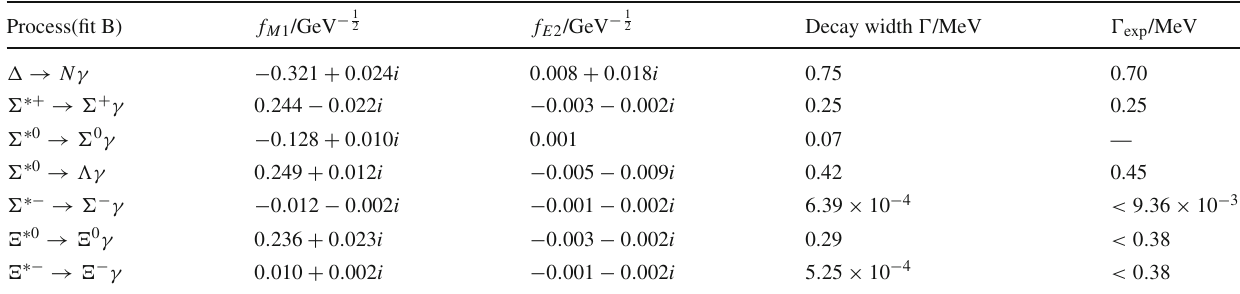
Table 14 M1 and E2 amplitudes and decay width of the decuplet to octet baryons in fit B. All the experimental values are from PDG